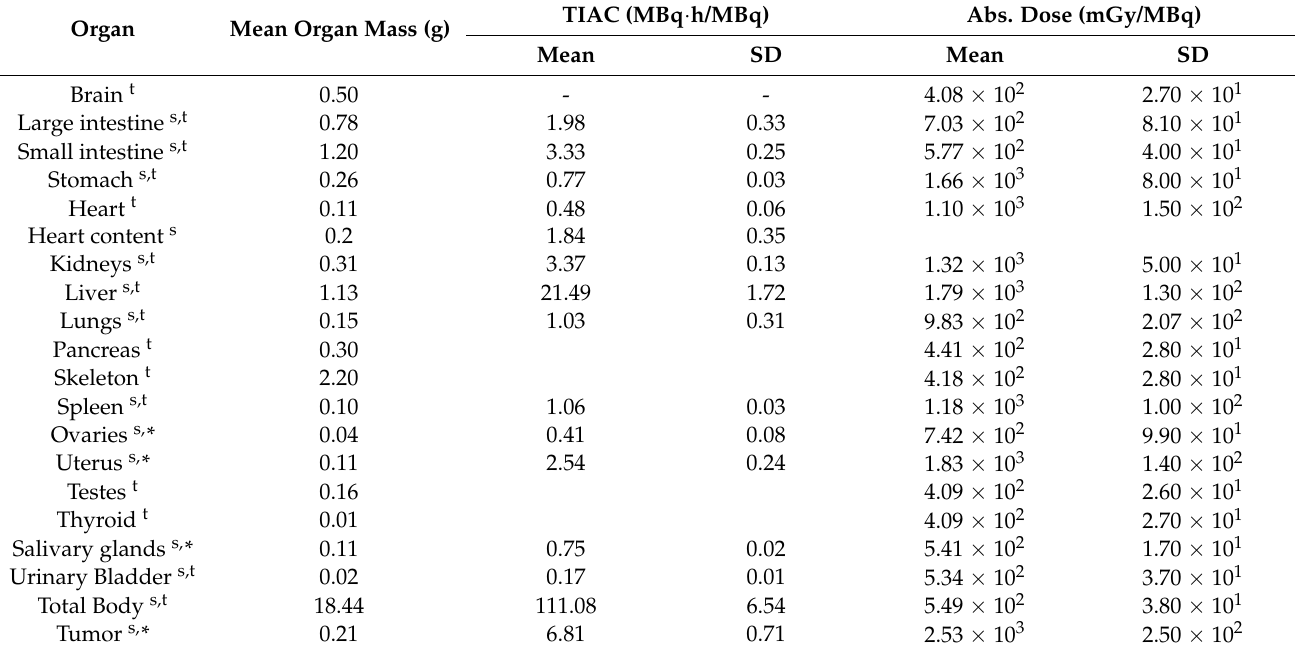
Table 3. Considered organ masses, estimated source organ TIAC and organ absorbed doses [ 177 Lu]Lu-1C1m-Fc. Organ masses of the 25g mouse model of Olinda/EXM 2.1 were used for: brain, thyroid, testes, skeleton, pancreas and the heart content, for all other organs we used the experimental mean masses.